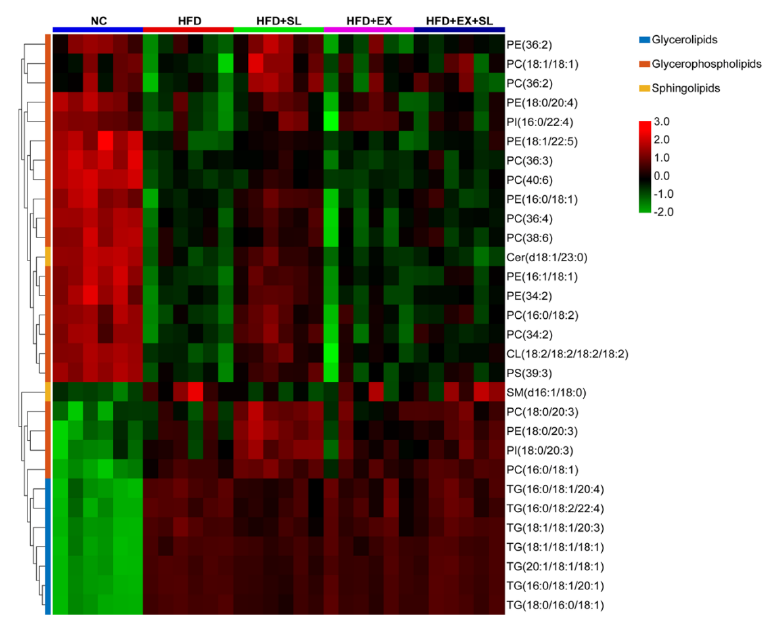
Figure 5. Heatmap of the differential lipid species among the five groups. Red denotes a relative increase, and green denotes a relative decrease. Table 1. List of the di ff erential lipid species of the five